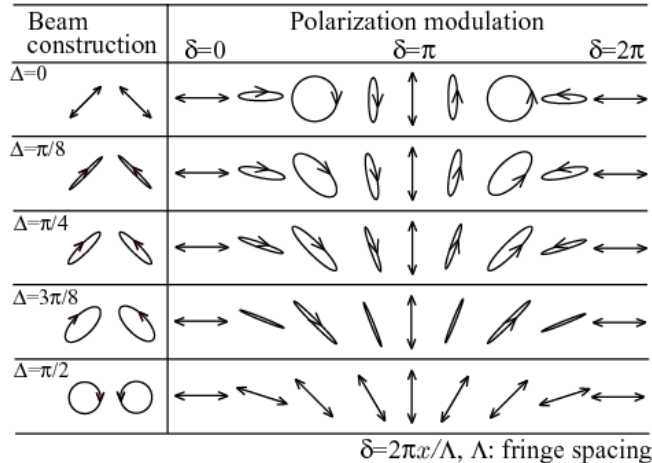
Figure 7. Optical arrangement for elliptic polarization interference irradiation. Δ is the phase difference in each elliptic polarization, and x is the lateral axis parallel to the grating